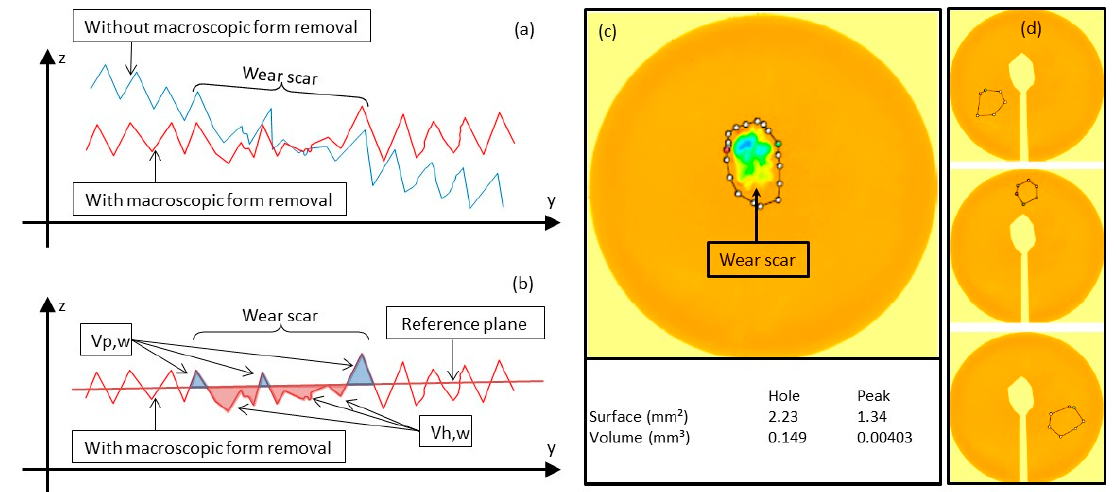
Figure 4. ( a ) Macroscopic form removal; ( b ) peak and hole volume measurement; ( c ) reference plane and volume of peak and hole; ( d ) non ‐ worn peak and hole volume measurement.